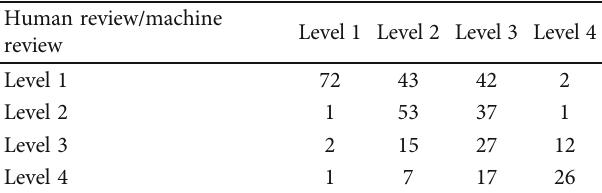
Table 3: The number of comparative samples of human-machine rating of surprise